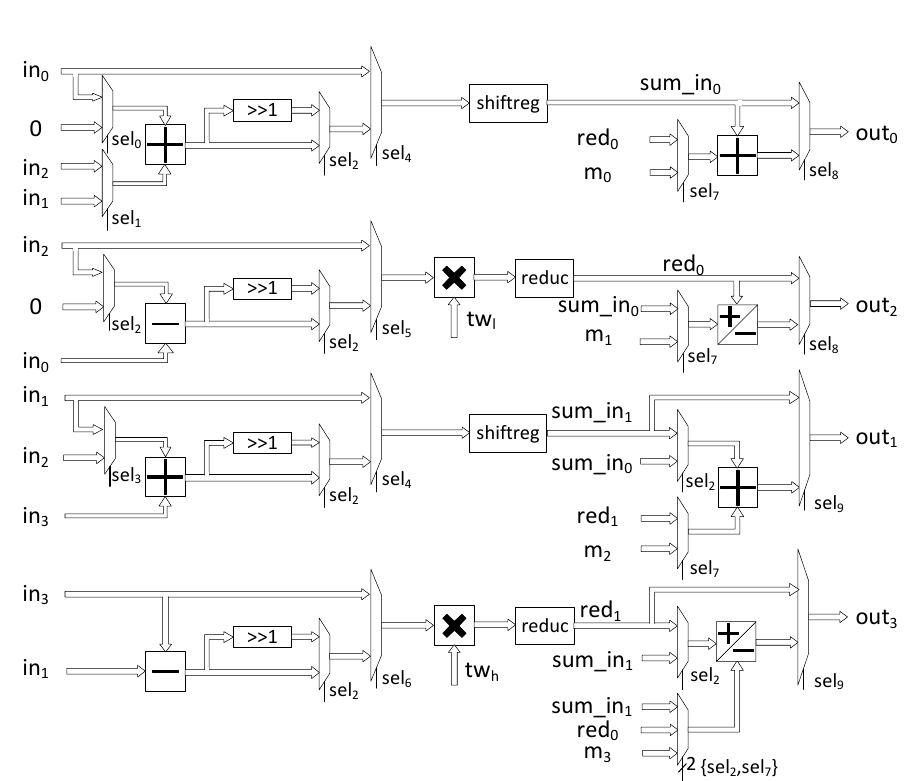
Figure 10: Structure of two sets of butterfly units. Each path is illustrated separately, with two input data pairs ( in 1 , in 0 ), ( in 3 , in 2 ) and corresponding output pairs ( out 1 , out 0 ), ( out 3 , out 2 ). Control codes in different operations are presented in Table